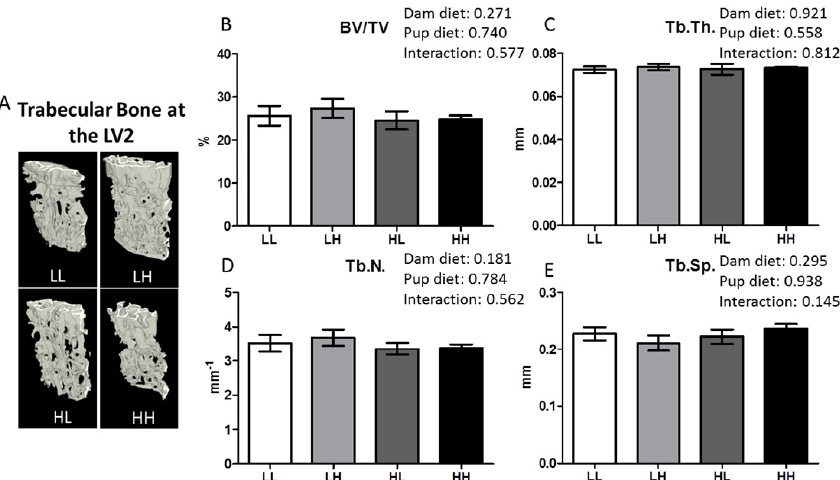
Figure 4. High dietary vitamin D does not impact trabecular bone quality at LV2 as determined using µ CT for mice seven months of age. ( A ) Representative µ CT images of one trabecular section from each group (LL: Low, Low; LH: Low, High; HL, High, Low; HH, High, High); ( B ) Trabecular bone volume as a percentage of tissue volume, BV/TV%; ( C ) Trabecular thickness, Tb.Th. (mm); ( D ) Trabecular number, Tb.N. (mm − 1 ); ( E ) Trabecular separation, Tb.Sp. (mm). Values are given as mean ± SEM, n = 6–8/group. Two-way ANOVA using “dam diet” and “pup diet” as main effects with significance between groups set at p < 0.05.